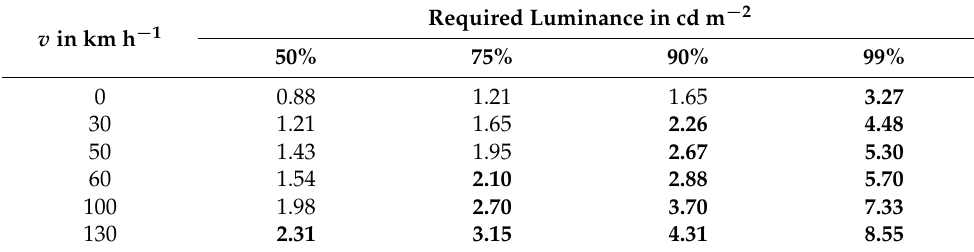
Table 5. Required average roadway luminance values for different probability thresholds at different speed levels. The bold numbers indicate the cases where the used standard LED headlights cannot provide the necessary roadway